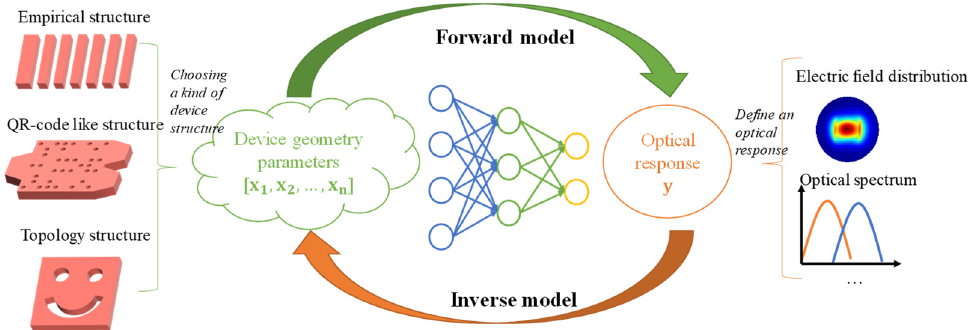
Figure 5. Schematic of DNN-assisted silicon photonic device design approach.